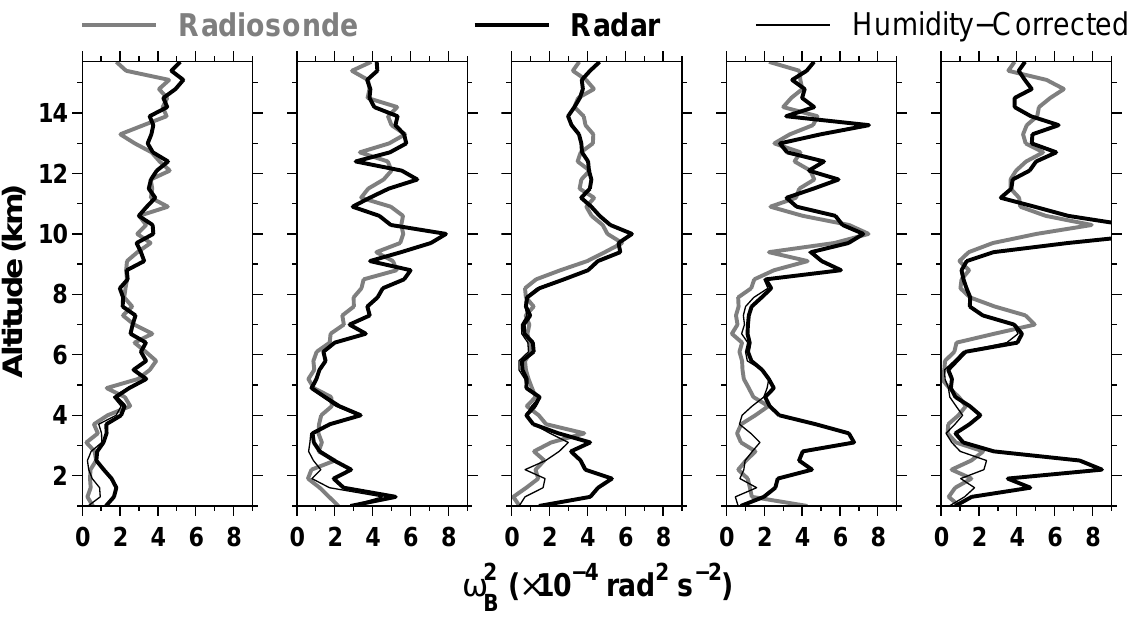
Fig. 3. A comparison of profiles of ω 2 derived from radiosonde data (thick grey lines), radar data (thick black lines) and humidity-corrected B radar data (thin black lines) corresponding (from left to right) to 07:37 UT on 21 January 2000, 10:50 UT on 10 March 1998, 07:37 UT on